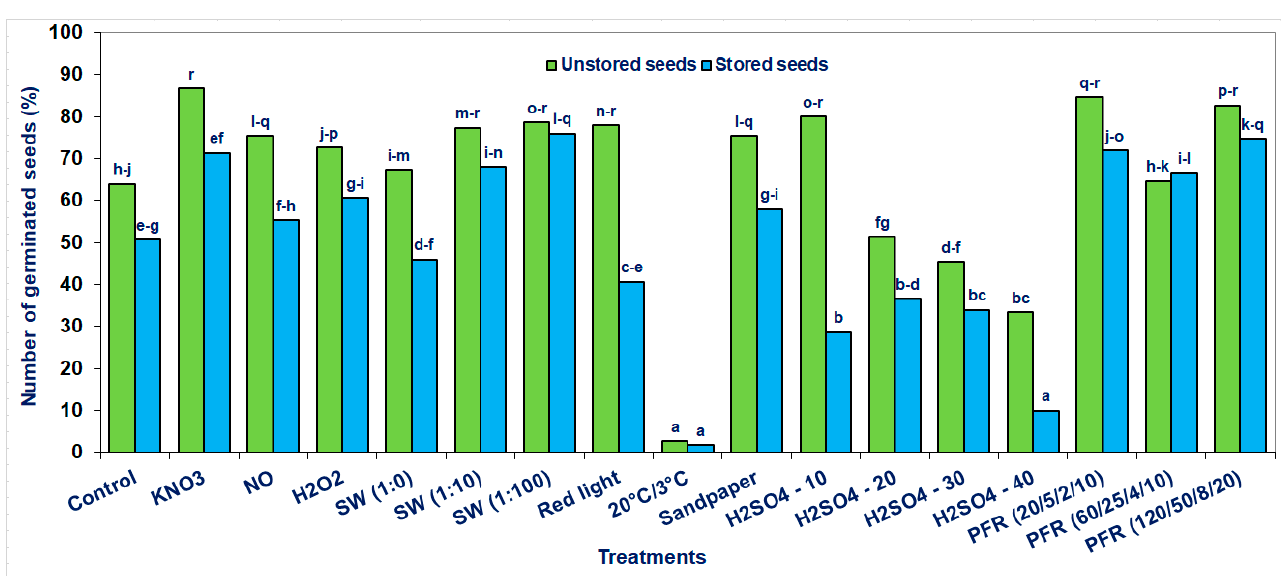
Figure 2. Seed germination of the Saskatoon berry after stratification (3 °C) in the presence of KNO 3 , NO, H 2 O 2 , smoke-water (SW, in concentrations of 1:1, 1:10, 1:100), or scarification: sandpaper, sulfuric acid for 10, 20, 30 and 40 min or treatments with pulsed radio frequency (PRF, 20/5/2/10, 60/25/4/10, 120/50/8/20), red light and 20 °C/3 °C. The seeds were harvested directly from fruits (unstored) and stored at − 18 °C for 6 months. The data within the graph (A or B) and the color of the bar and with the same letter do not differ significantly according to Tukey’s test (5%). Values are the means of three replications of 50 seeds.